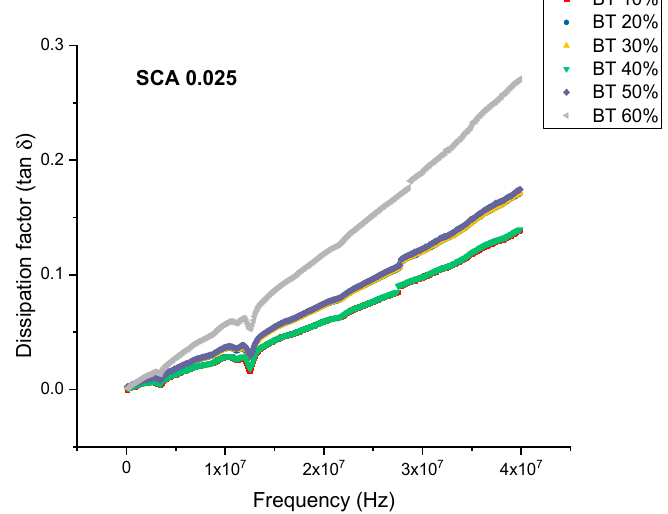
Figure 16. The dissipation factor of the BaTiO 3 -epoxy composite that were fabricated using BaTiO 3 nanoparticles which were surface modified using 0.025 SCA is plotted as a function of frequency where the volume fraction of BaTiO 3 is varied from 0.1 to 0.6. The maximum value is 0.119 for BaTiO 3 at 0.6 volume fraction.